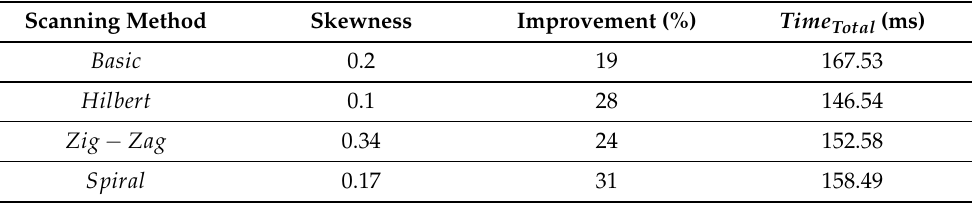
Table 7. Three-dimensional (3D) NI-SPI performance summary under foggy